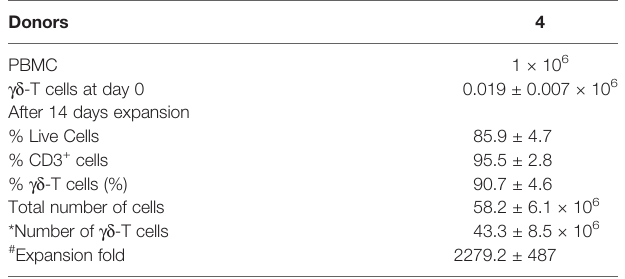
TABLE 1 | In vitro expanded of gd T cells from freshly isolated PBMCs in response to zoledronate (1 µM).